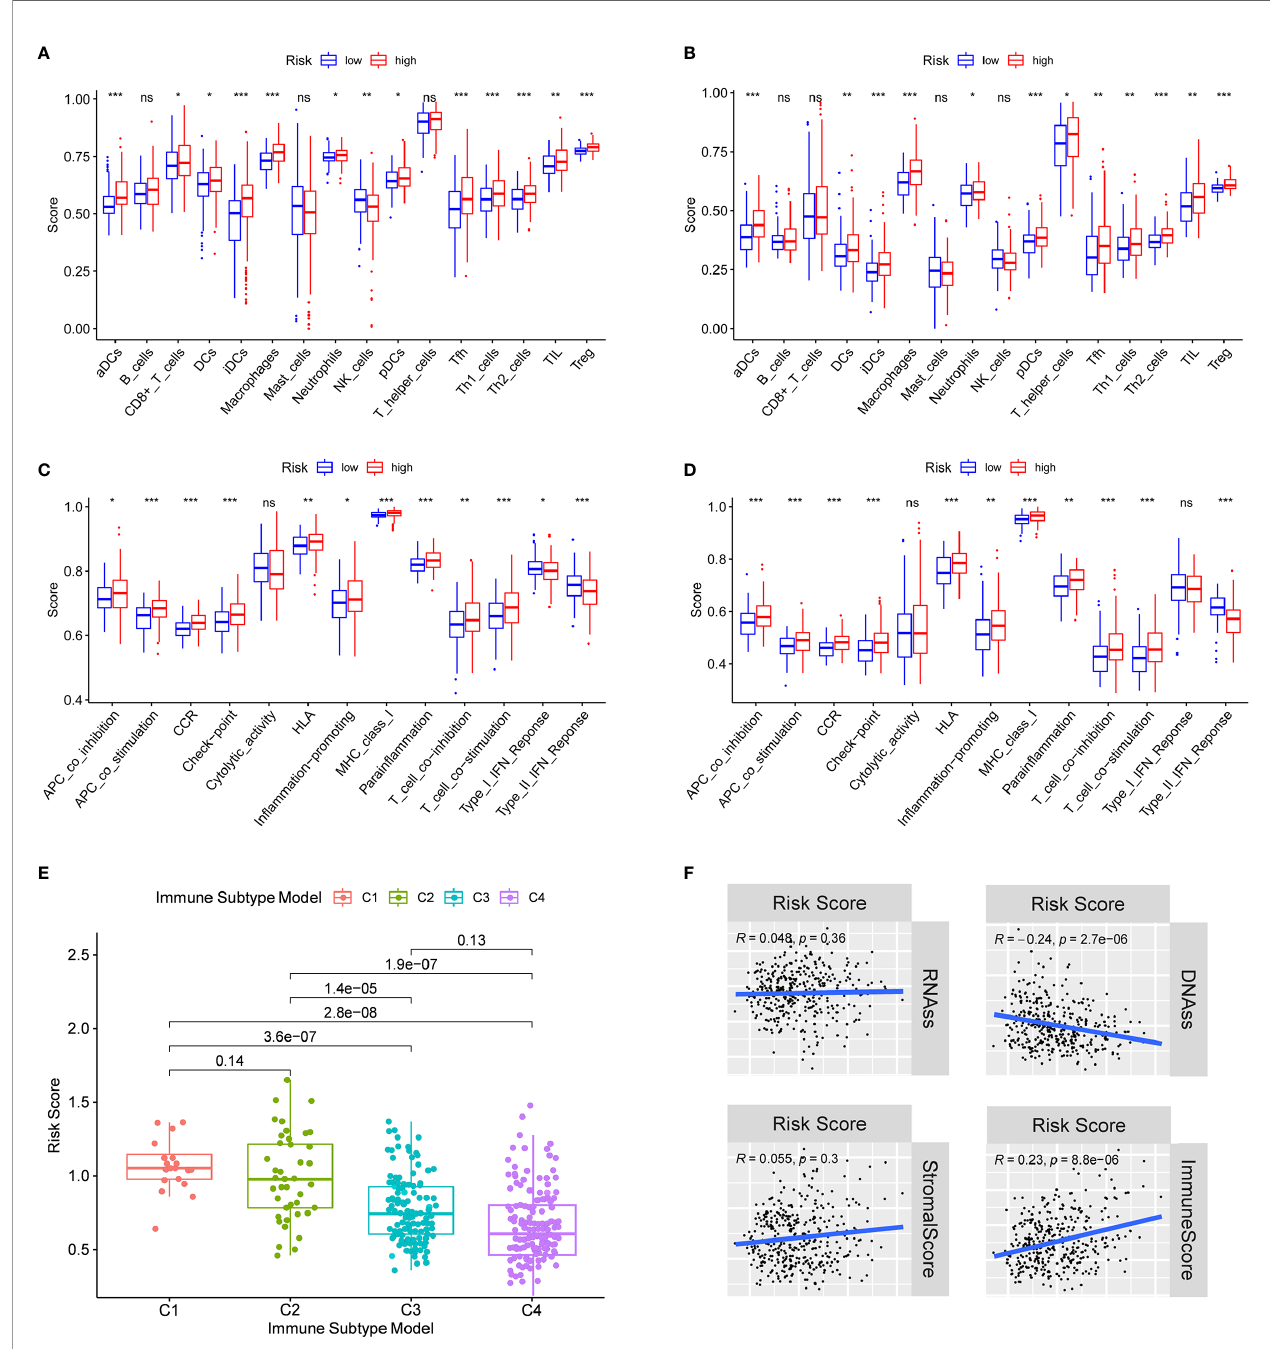
FIGURE 6 | Immune status between different risk groups and the association between risk score and tumor microenvironment. TCGA cohort (A, C) , ICGC cohort (B, D) . (A, B) The scores of 16 immune cells and (C, D) 13 immune-related functions were showed in boxplots. (E) Comparison of the risk score in different immune in fi ltration subtypes. (D) The relationship between risk score and RNAss, DNAss, Stromal Score and Immune Score. P values were showed as: ns, not signi fi cant; *P < 0.05; **P < 0.01; ***P <